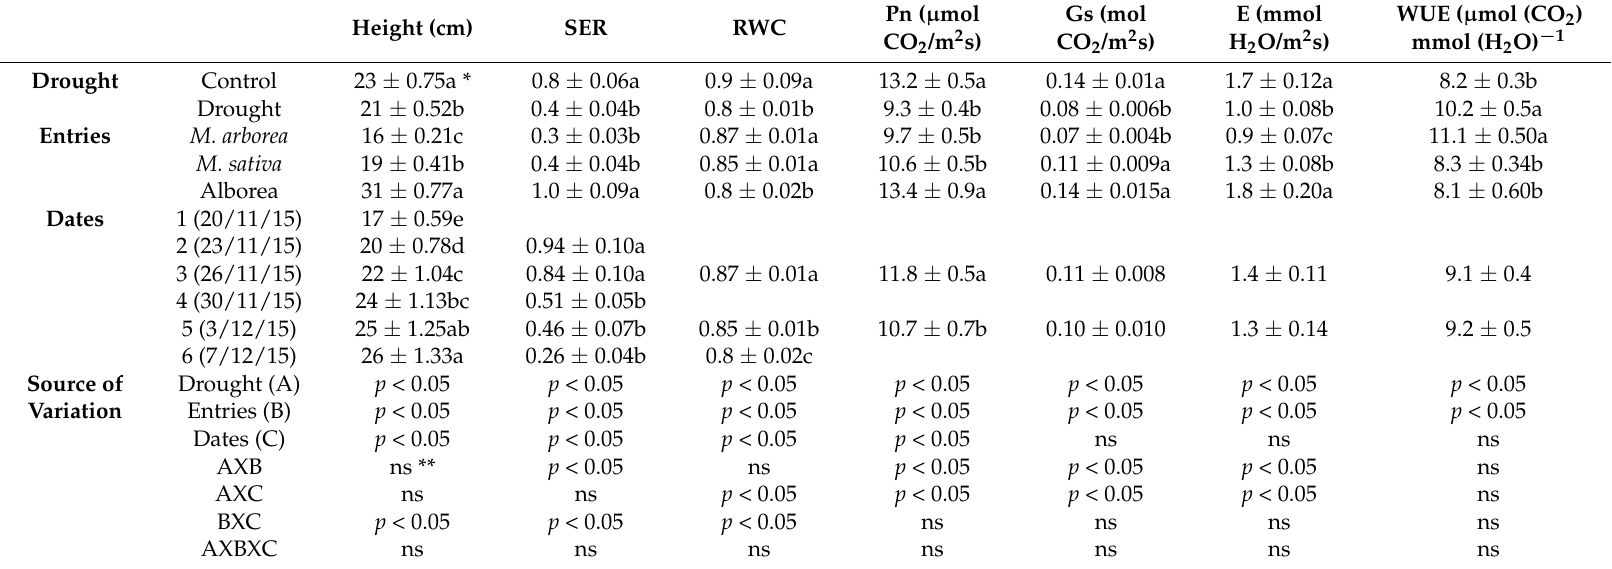
Table 2. The height of seedlings, Stem Elongation Rate (SER), Relative Water Content (RWC), Photosynthetic rate (Pn), Stomatal conductance, transpiration rate (E), Water Use Efficiency (WUE) of the seedlings (mean ± SE) under the control and the drought